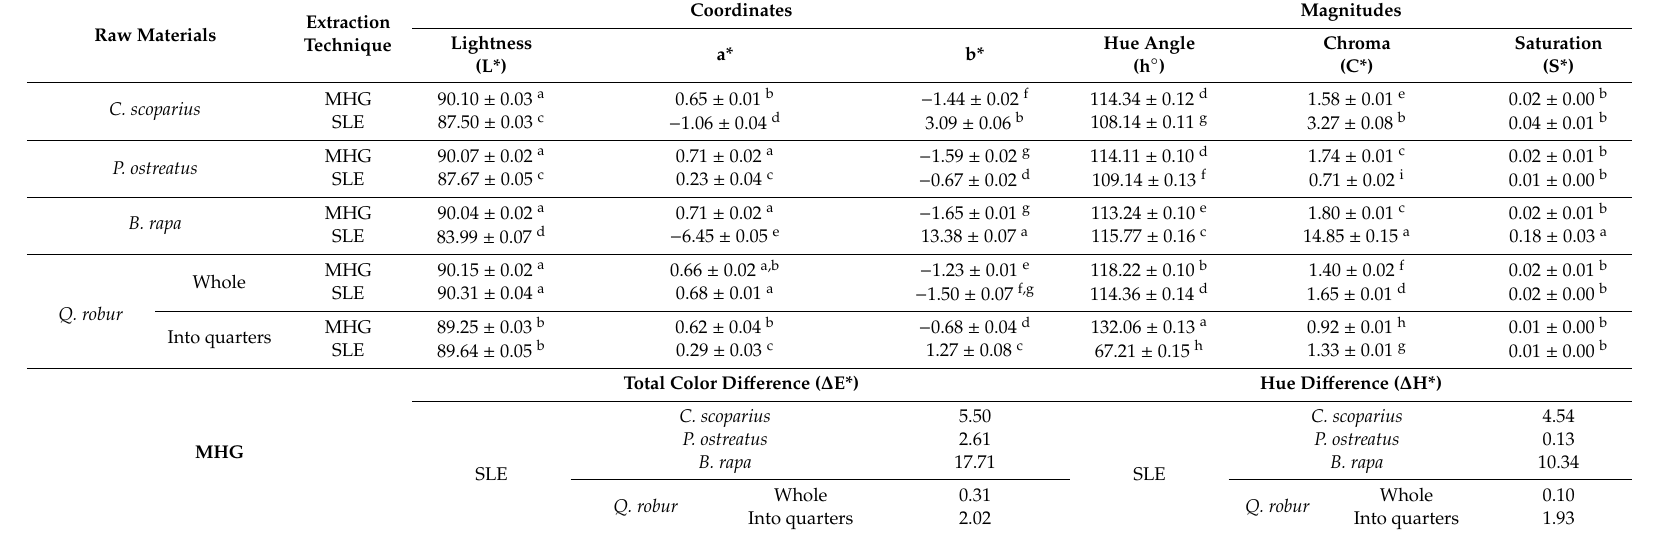
Table 2. Colorimetric features by CIEL*a*b* system from the aqueous phase collected at 100 W by MHG extraction and solid liquid extraction of the di ff erent raw